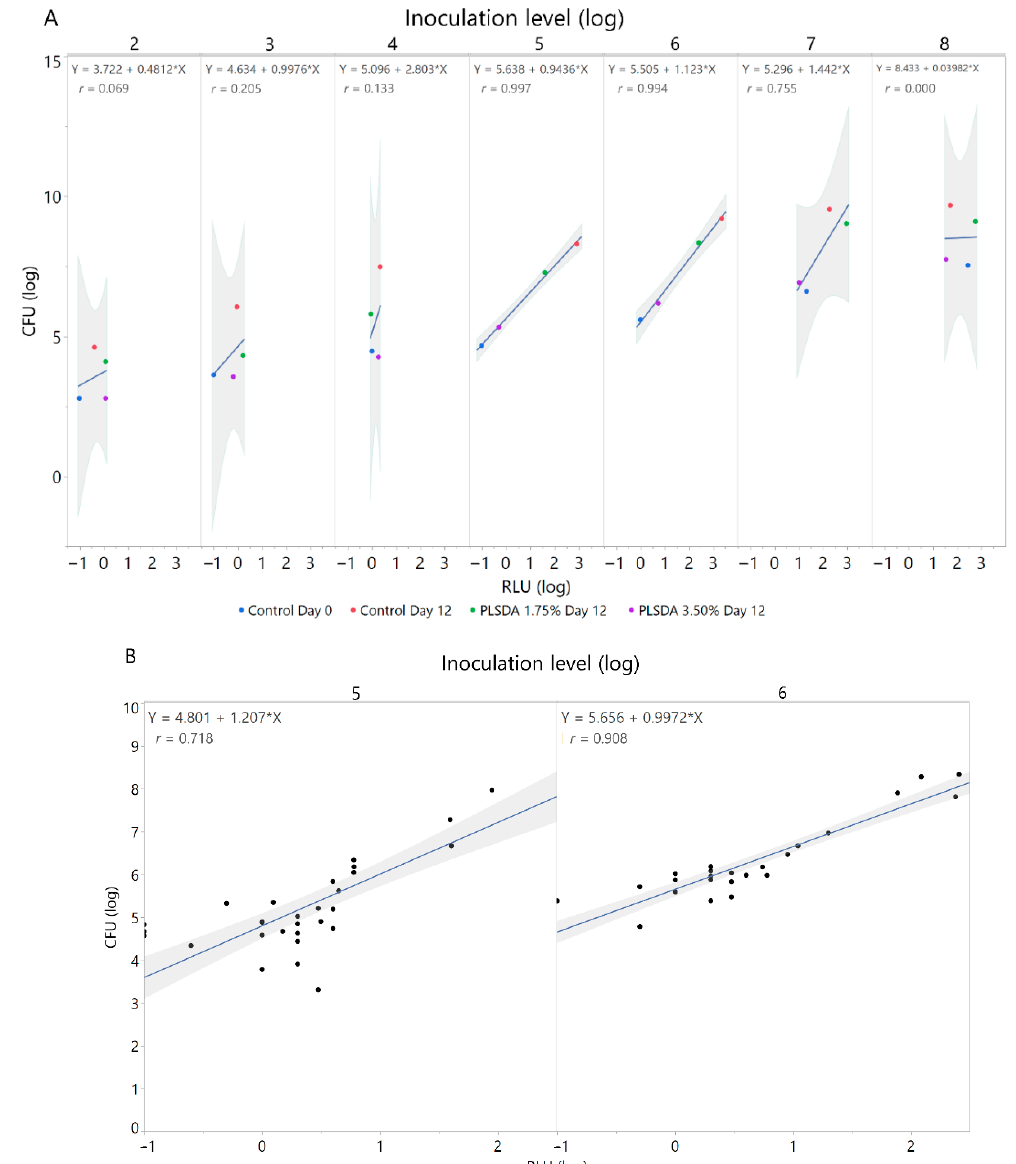
Figure 3. Correlation of CFU and RLU at multiple inoculation levels. The shaded region shows the 95% confidence intervals. ( A ) Preliminary screening with limited antimicrobials with inoculation levels ranging from 2 to 8 log CFU/g. ( B ) Additional trials for the inoculation levels with the best initial correlation coefficients (5 and 6 log CFU/g). See text for treatment details.